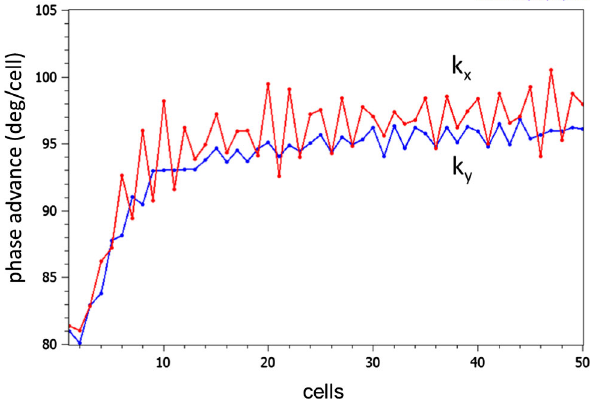
FIG. 5. rms phase advances versus cell number for waterbag example of Fig. 4.